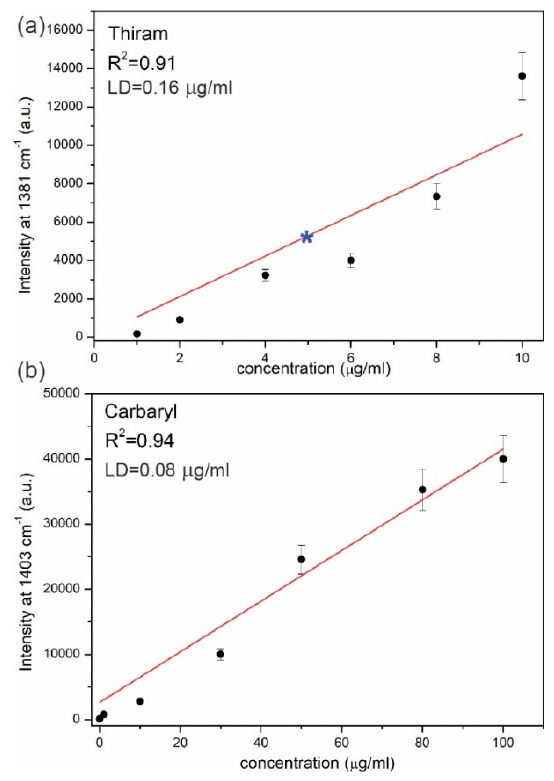
Figure 7. Calibration curves for Thiram ( a ) and Carbaryl ( b ) pesticides. Each point is based on the average SERS spectra taken in five different places on the PET/ITO/Ag platform. The error bars indicates 9% deviation at a chosen band. Star corresponds to the intensity of the 1381 cm − 1 band in the SERS spectrum of the apple juice with Thiram pesticide. The limit of detection (LD) for Thiram is 0.16 µg/mL, whereas for Carbaryl it is 0.08 µg/mL.